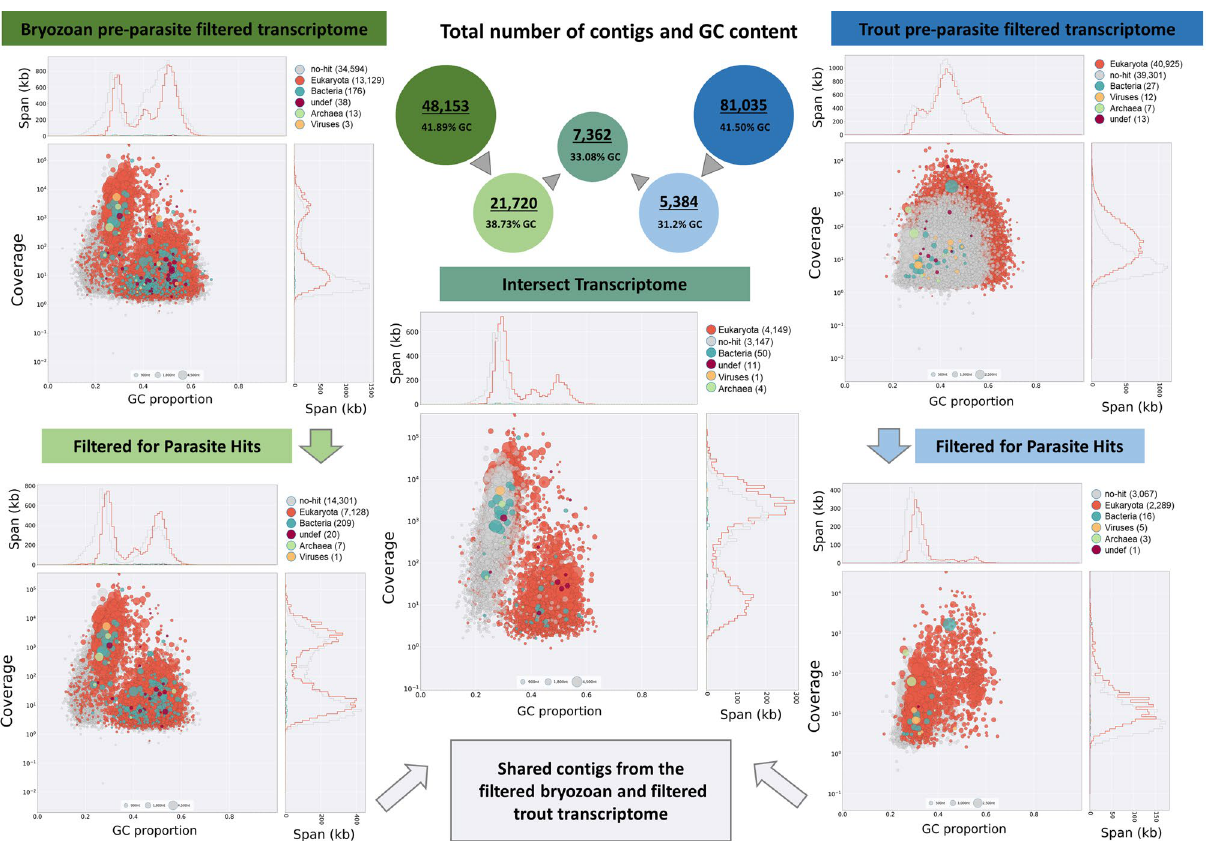
Figure 1. Generation of the T. bryosalmonae intersect transcriptome from spore sacs and fish kidney tissues. The contigs derived from each host assembly were filtered against the T. kitauei genome and/or a T. bryosalmonae genome sequence dataset to remove host contamination. The intersect transcriptome was generated by BLASTing the bryozoan parasite-filtered contigs against the trout parasite-filtered contigs, resulting in 7362 predicted contigs. The graphs show a BlobPlot of each contig assembly by phylum, with contigs positioned on the X-axis based on their GC proportion and on the Y-axis based on the sum of coverage. Sequence contigs in the assembly are depicted as circles, with diameter scaled proportional to sequence length and coloured by taxonomic Tb RPL18 (20.00/24.51), Tb RPL12 (20.77/25.03) and Tb ELFα (18.73/23.74). Similarly, uninfected/infected fish kidney and bryozoan cDNA samples yielded a mean Cq value of 11.02 and 14.58 for rainbow trout and bryozoan ELFα respectively (Marc N. Faber unpublished data). Coefficient of variation (CV%) values were similar for all three reference genes ( Tb RPL12 = 9.39; Tb RPL18 = 10.09; Tb ELFα = 11.65). This implies that Tb RPL12 and Tb RPL18 were slightly more stable as ref- erence genes than Tb ELFα with primer efficiency of Tb RPL18 amplification (1.94; 97%) being slightly higher than that for Tb RPL12 (1.90; 95%). Relative expression normalised to each reference gene individually revealed the same repertoire of significant and non-significant genes. Thus, gene expression data, overall, are presented normalised to Tb RPL18, which has been used to determine T. bryosalmonae load in trout kidney samples in previous studies 33,34 . Δ Cq values were calculated representing the expression level of genes of interest compared to Tb RPL18 in each infected host with values > 1 indicating lower expression and values < 1 indicating higher expression compared to Tb RPL18 (Figs. 5, 6, 78). Fold differences in gene expression in infected fish relative to infected bryozoans were assessed for each gene of interest and presented as fold differences in gene expression in Supplementary Table S5. Gene names were assigned according to the closest BLAST search using protein similarity search based on the manually annotated UniProtKB/Swiss-Prot and UniProtKB/Swiss-Prot isoforms databases (https ://www.ebi.ac.uk/Tools /sss/fasta /). Highest BLAST hits are listed alongside predicted functional